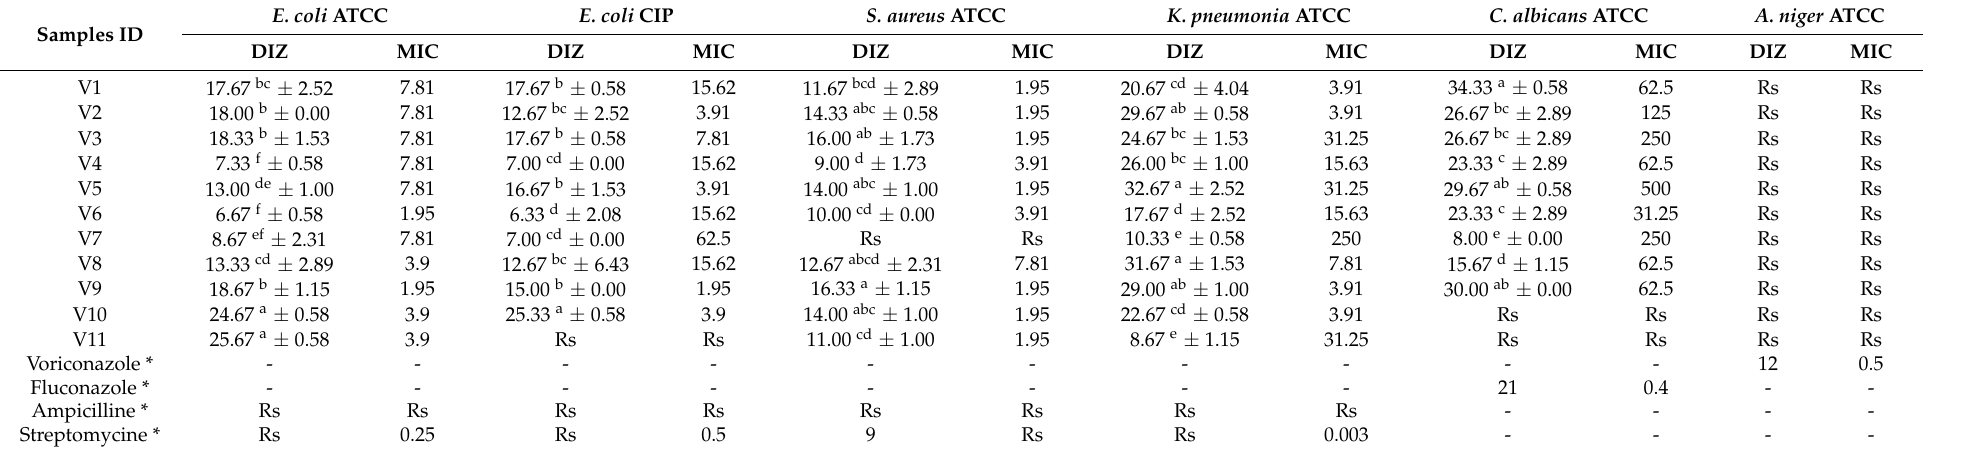
Table 2. Antimicrobial activity of the different vinegars against various